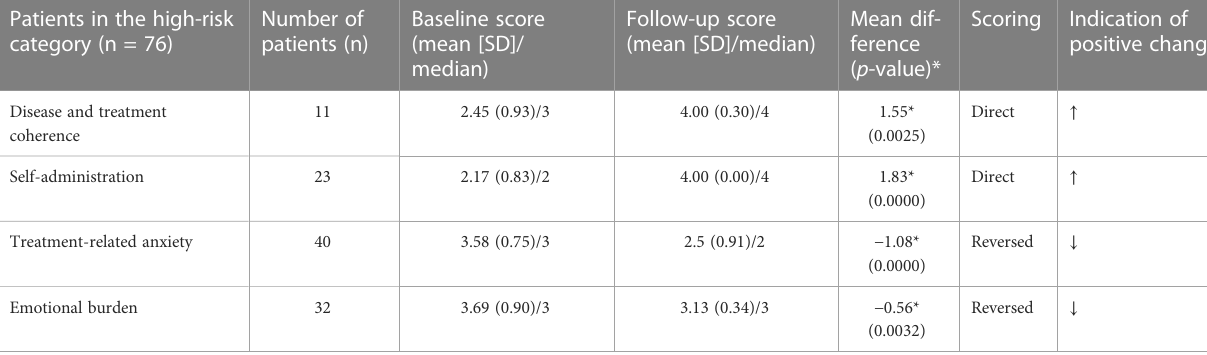
TABLE 2 Changes in caregiver scores between baseline and follow-up evaluations.